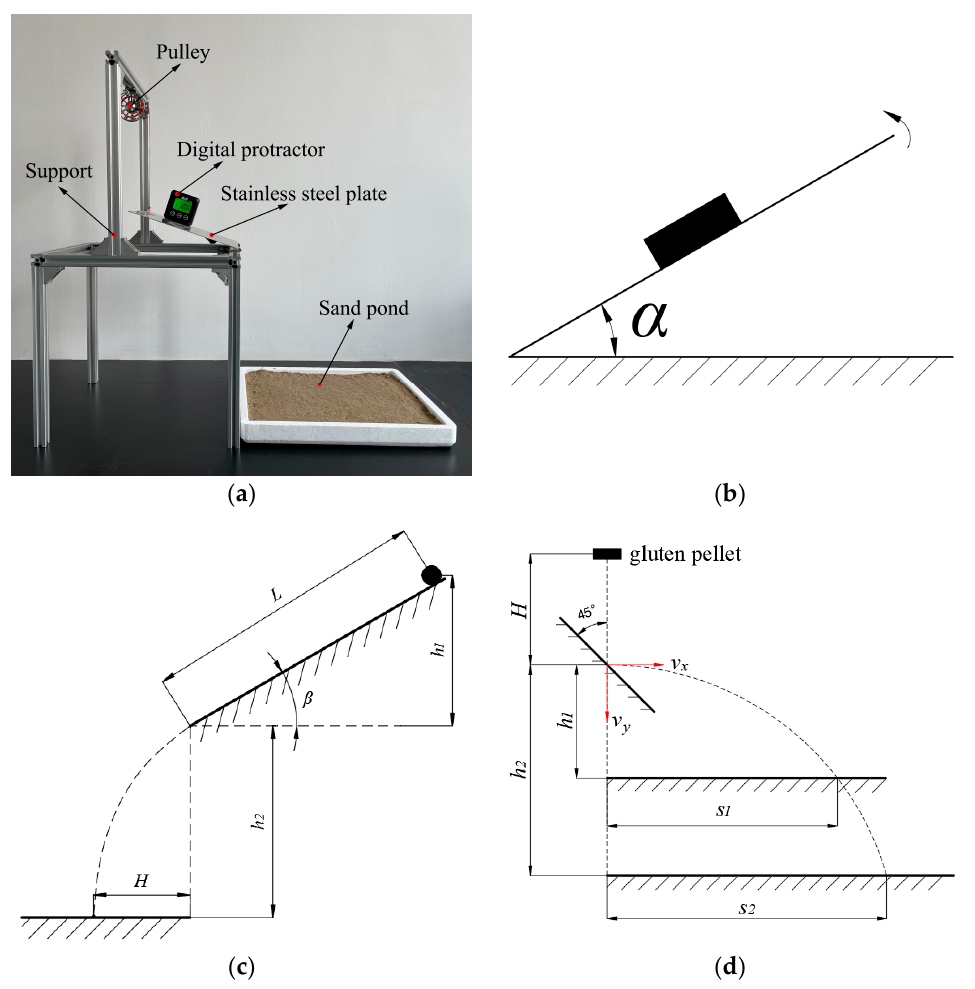
Figure 4. The measurement detection device and principle. ( a ) The measurement detection device; ( b ) static friction coefficient measurement principle; ( c ) rolling friction coefficient measurement principle; and ( d ) restitution coefficient measurement